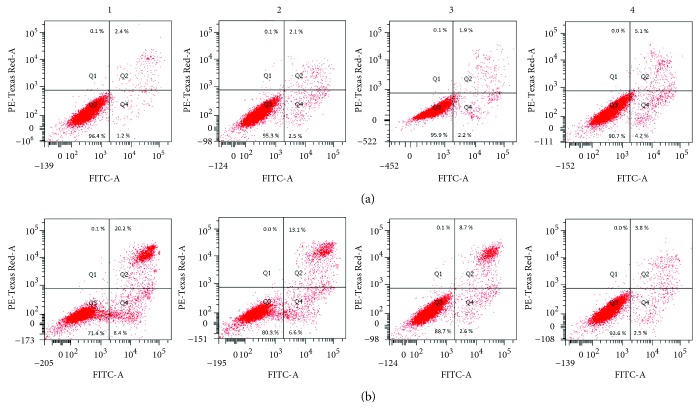
Effects of arsenic and/or grape seed procyanidin extract on apoptosis. (a1) The control group showed normal levels of L-02 cell apoptosis. The percentage of apoptotic cells was less than 5%. (a2–a4) GSPE (10, 25, and 50 mg/L for 24 h) treatment groups showed normal L-02 cell apoptosis compared with the control group. In the arsenic (25 μM for 24 h) treatment group, apoptosis increased significantly and was mainly advanced apoptosis (20.2%). (b2–b4) The arsenic (25 μM) + GSPE (10, 25, and 50 mg/L) group (for 24 h) showed gradual decrease in apoptosis with increase in GSPE concentrations.